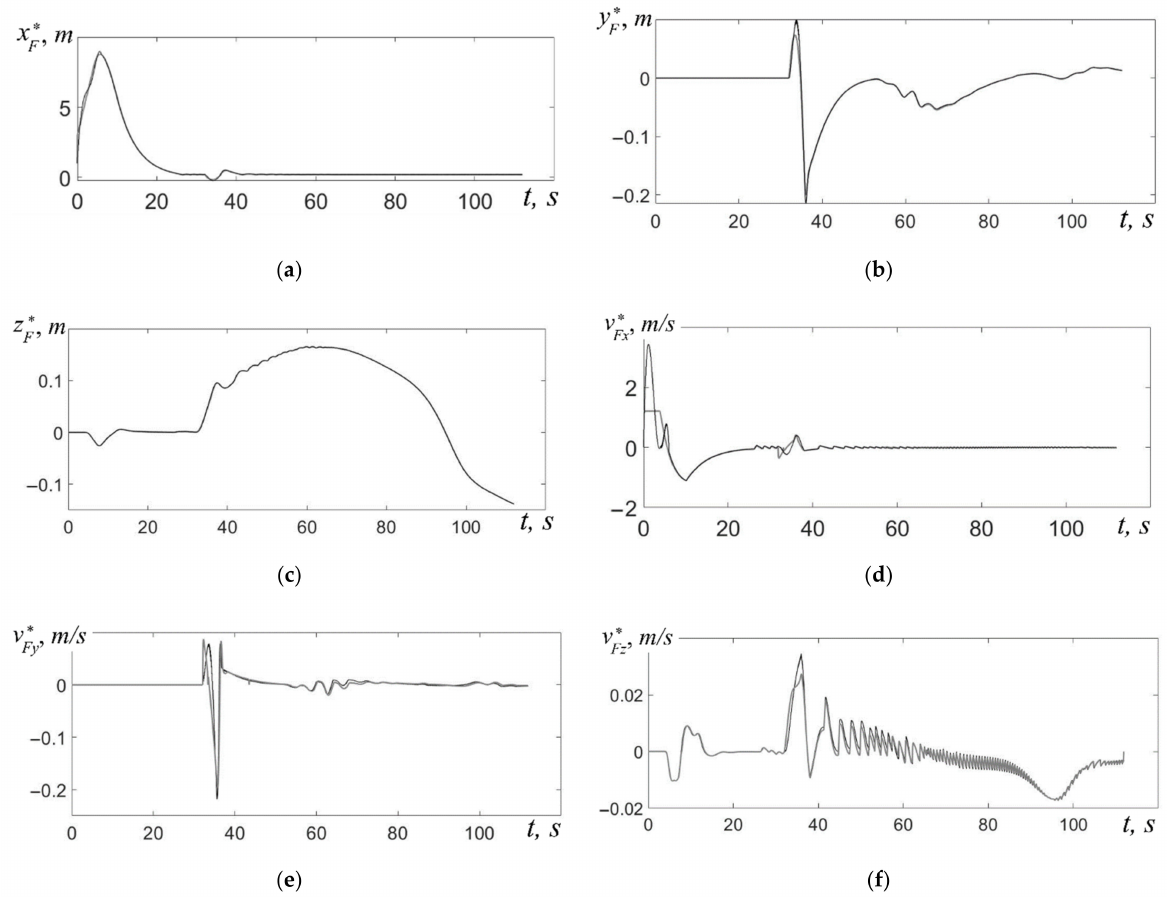
Figure 6. The changing estimated and true values of coordinates (( a ) is the x ∗